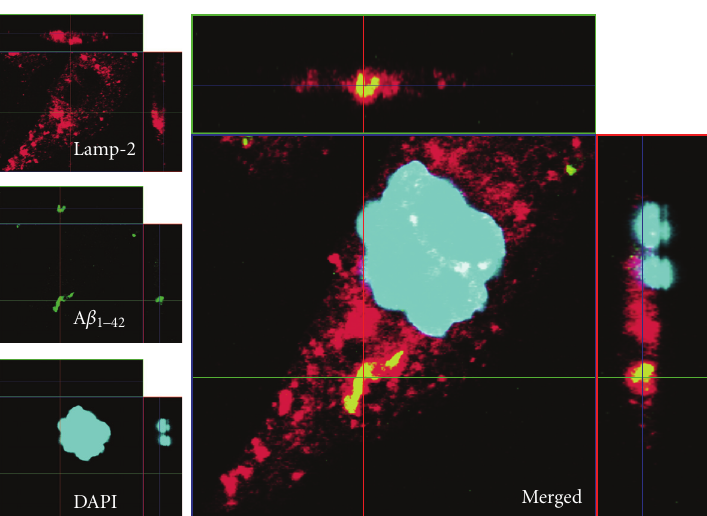
Figure 2: Uptake of A β 1 – 42 in human microglial cells. The confocal micrograph (63 × ) shows fixed CHME3 microglial cells demonstrating intracellular lysosomal location of HiLyte488-conjugated A β 1 – 42 (green filter). Lysosomes were visualized by staining with an antibody against lysosome-associated membrane protein-2 (lamp-2) and Cy3-conjugated secondary antibodies (red filter). Yellow colour thus indicates colocalization of lamp-2 and HiLyte488-conjugated A β 1 – 42